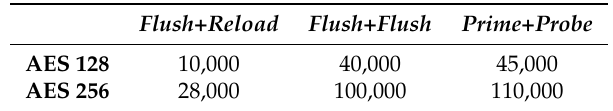
Table 3. Mean number of samples required to retrieve the whole key in virtualized environments (cross-VM).